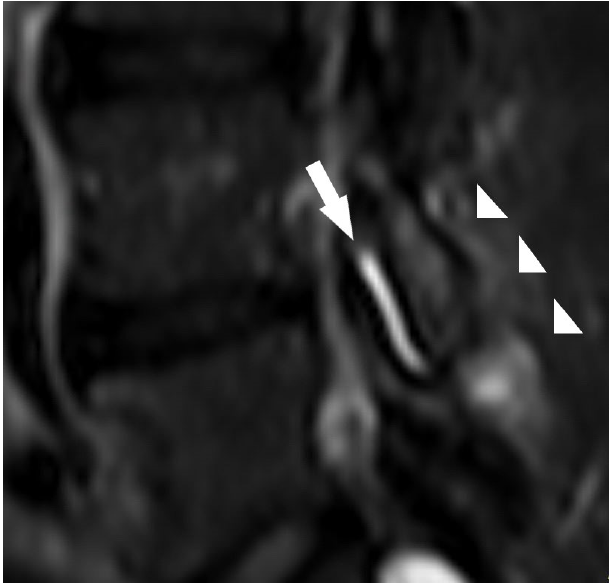
Figure 3. Magnetic resonance image showing the LBLP case with facet effusion (arrow), bone marrow, and surrounding soft-tissue edema (arrowheads).